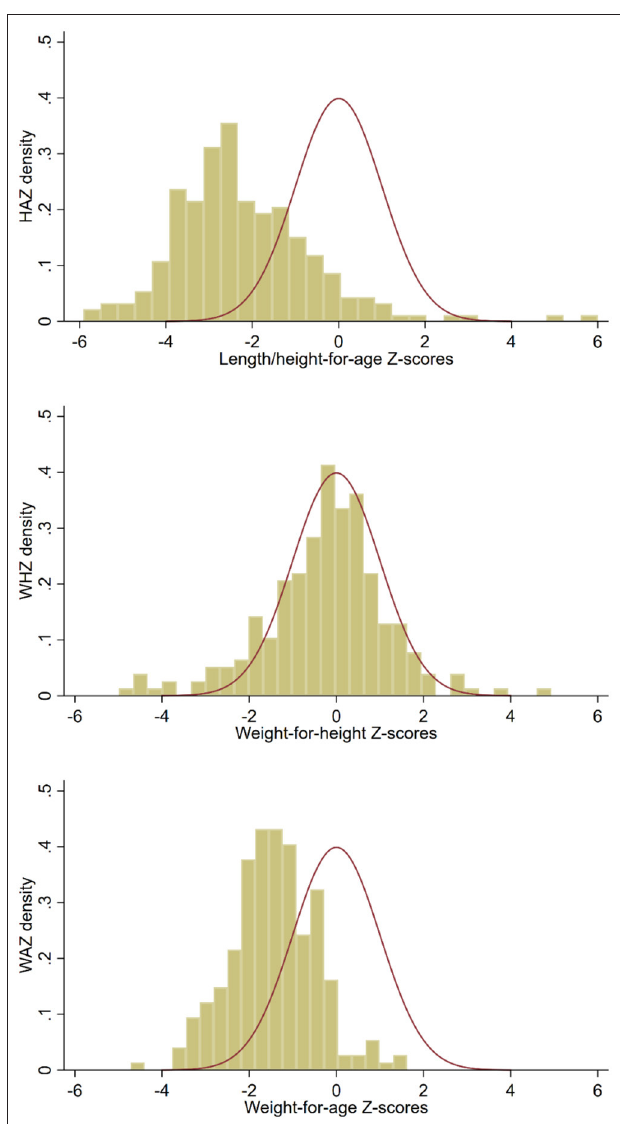
FIGURE 2 | HAZ, WHZ, and WAZ of sampled children in Lao Cai province. Note: WHO child growth standards are shown in standard normal densities. Source: Vietnam Rural Household Survey (July–August